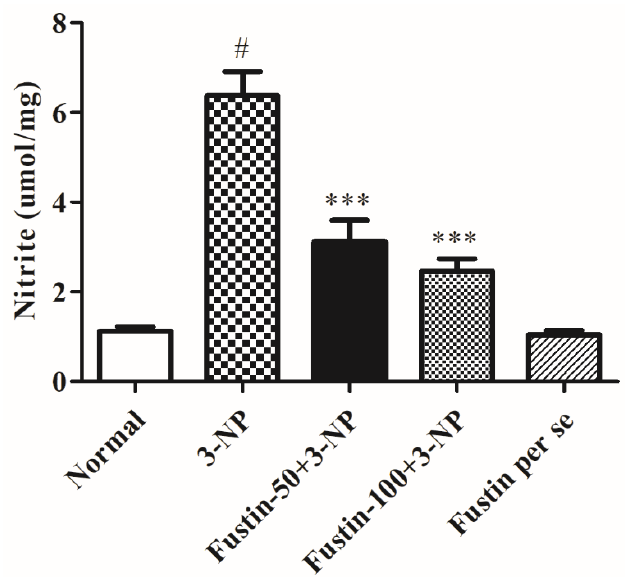
Figure 10. Effect of fustin nitrite level against 3-nitropropionic acid-induced Huntington’s-like effects in rats. Values are expressed as mean ± S.E.M. ( n = 6). Values are statistically significant at # p < 0.05 vs. negative control group, *** p < 0.001 vs. 3-nitropropionic acid, respectively (One-way ANOVA followed by Tukey’s test).